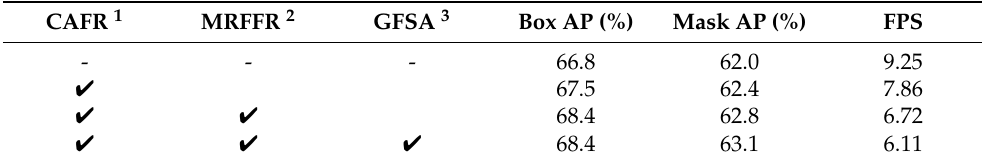
Table 5. Quantitative Results Component Analysis in GCIM-Block.